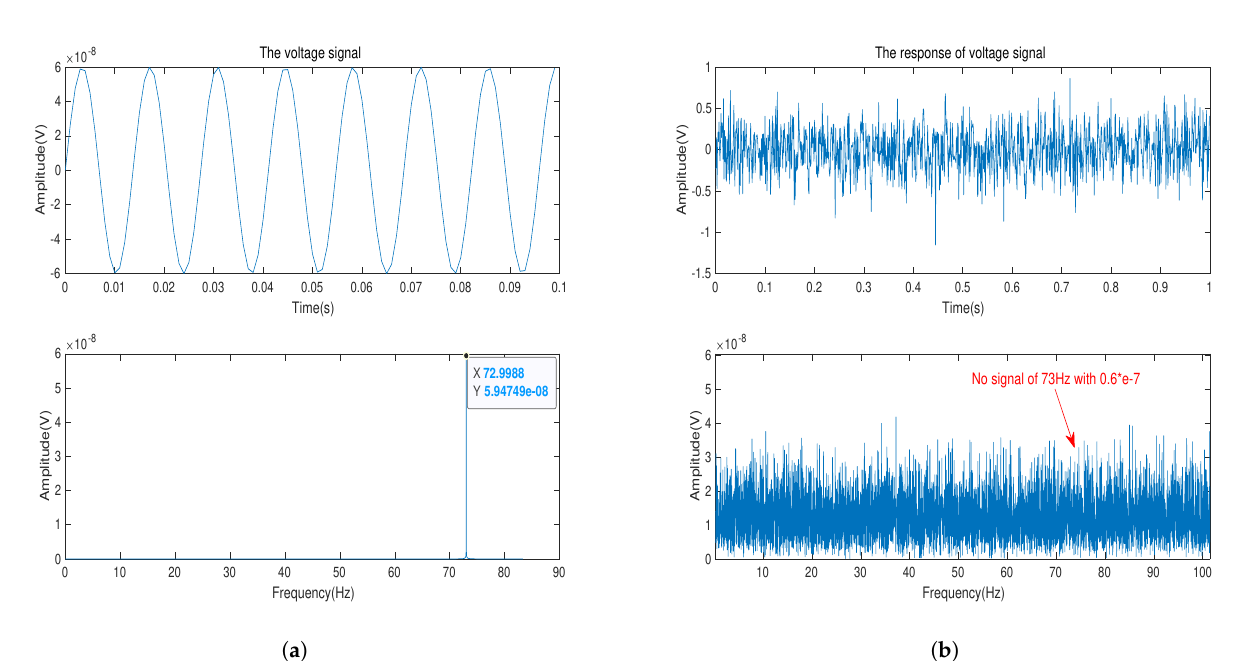
Figure 7. ( a ) The input-voltage signal with amplitude of 0.6 × 10 − 7 V and its frequency spectrum. ( b ) The acquisition voltage signal in time-domain and its frequency spectrum after time gain of 24 h. Figure 9a provides the input voltage signal and its frequency spectrum. After 168 h of data collection, we get the signal and its frequency spectrum in Figure 9b. With time gain of 96 h, background noise is suppressed to 0.1 × 10 − 10 V. We can observe that there is no signal with amplitude of 0.1 × 10 − 10 V and frequency of 73 Hz on the frequency spectrum. That explains that when the amplitude of input voltage signal is 0.1 × 10 − 10 V, the bipolar transistor of material GaAs does not sense the input signal.